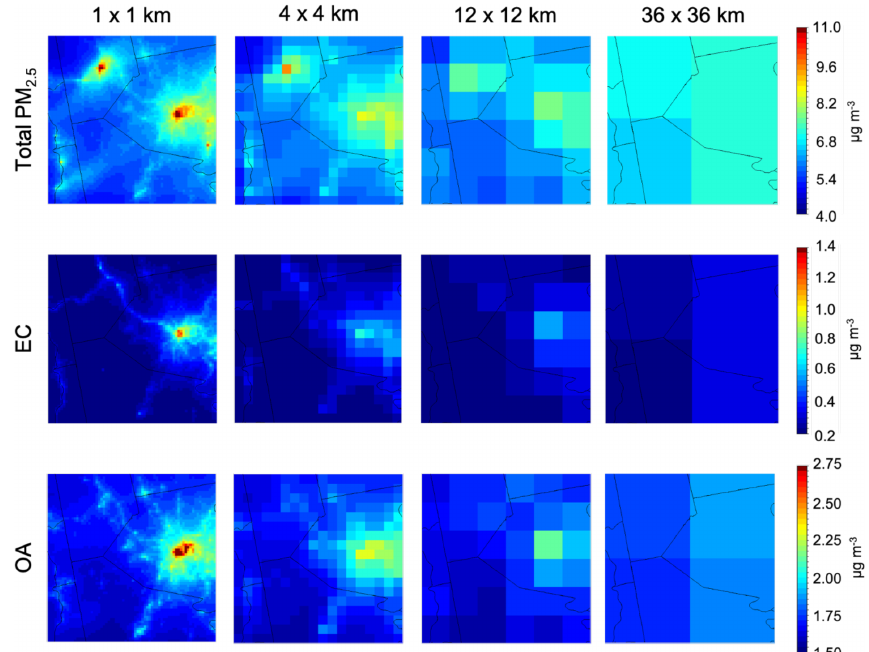
Figure 6. Average predicted concentration at the ground level of total PM 2 . 5 , EC, and OA at a 36 × 36, 12 × 12, 4 × 4, and 1 × 1km resolution during July 2017. Different color scales that do not start from zero are used for the various